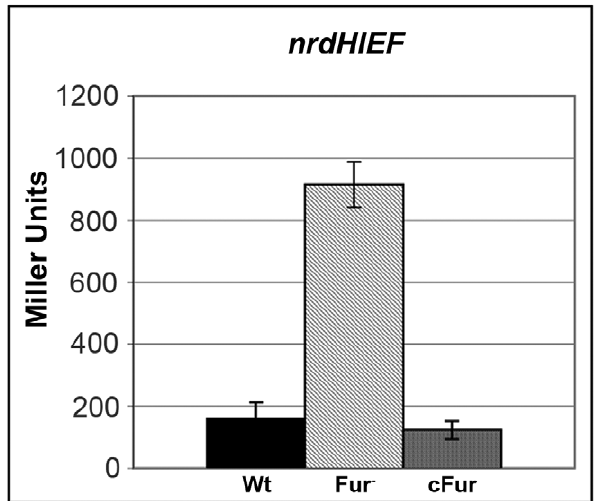
Figure 2. Fur-dependent expression of nrdHIEF. Effect of D fur mutation on nrdHIEF expression. b -galactosidase activity is expressed in Miller Units (MU) for the wild-type strain (Wt), mutant D fur strain (Fur - ), and complemented mutant strain (cFur). Results are the mean values of duplicates of at least three independent experiments. Error bars represent the standard deviation of experiments.